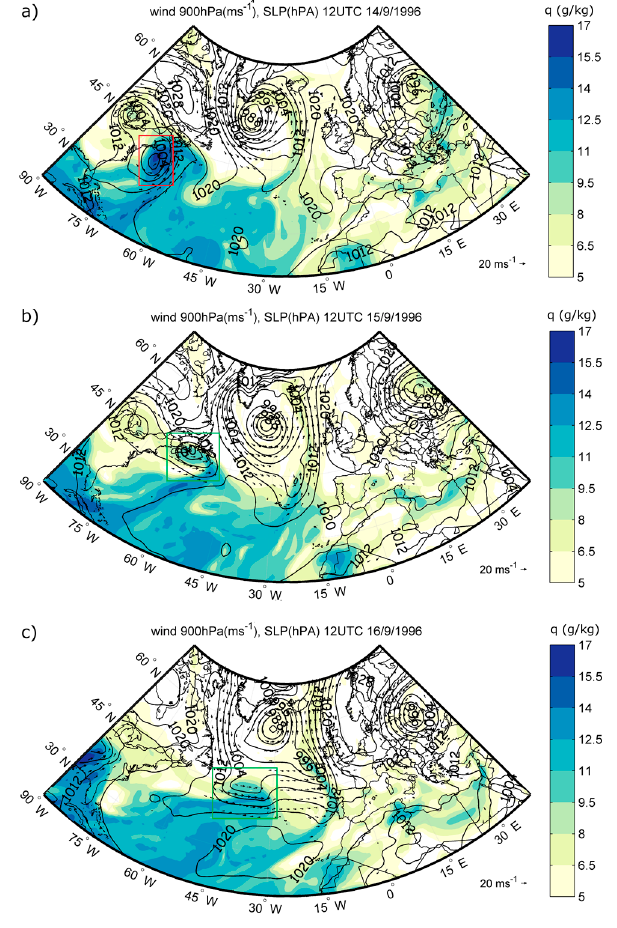
Figure 9. The wind field (vectors, m/s) and specific humidity (shaded, g/kg) at 900 hPa are shown along with the Sea Level Pressure (SLP, contours, hPa) on the ( a ) 14 September 1996 at 12 UTC; ( b ) 15 September 1996 at 12 UTC and ( c ) 16 September 1996 at 12 UTC. In addition, Hurricane Hortense is highlighted with a red square, while it’s extra-tropical transition is highlighted with a green square. Only winds speeds above 10 m/s are shown.